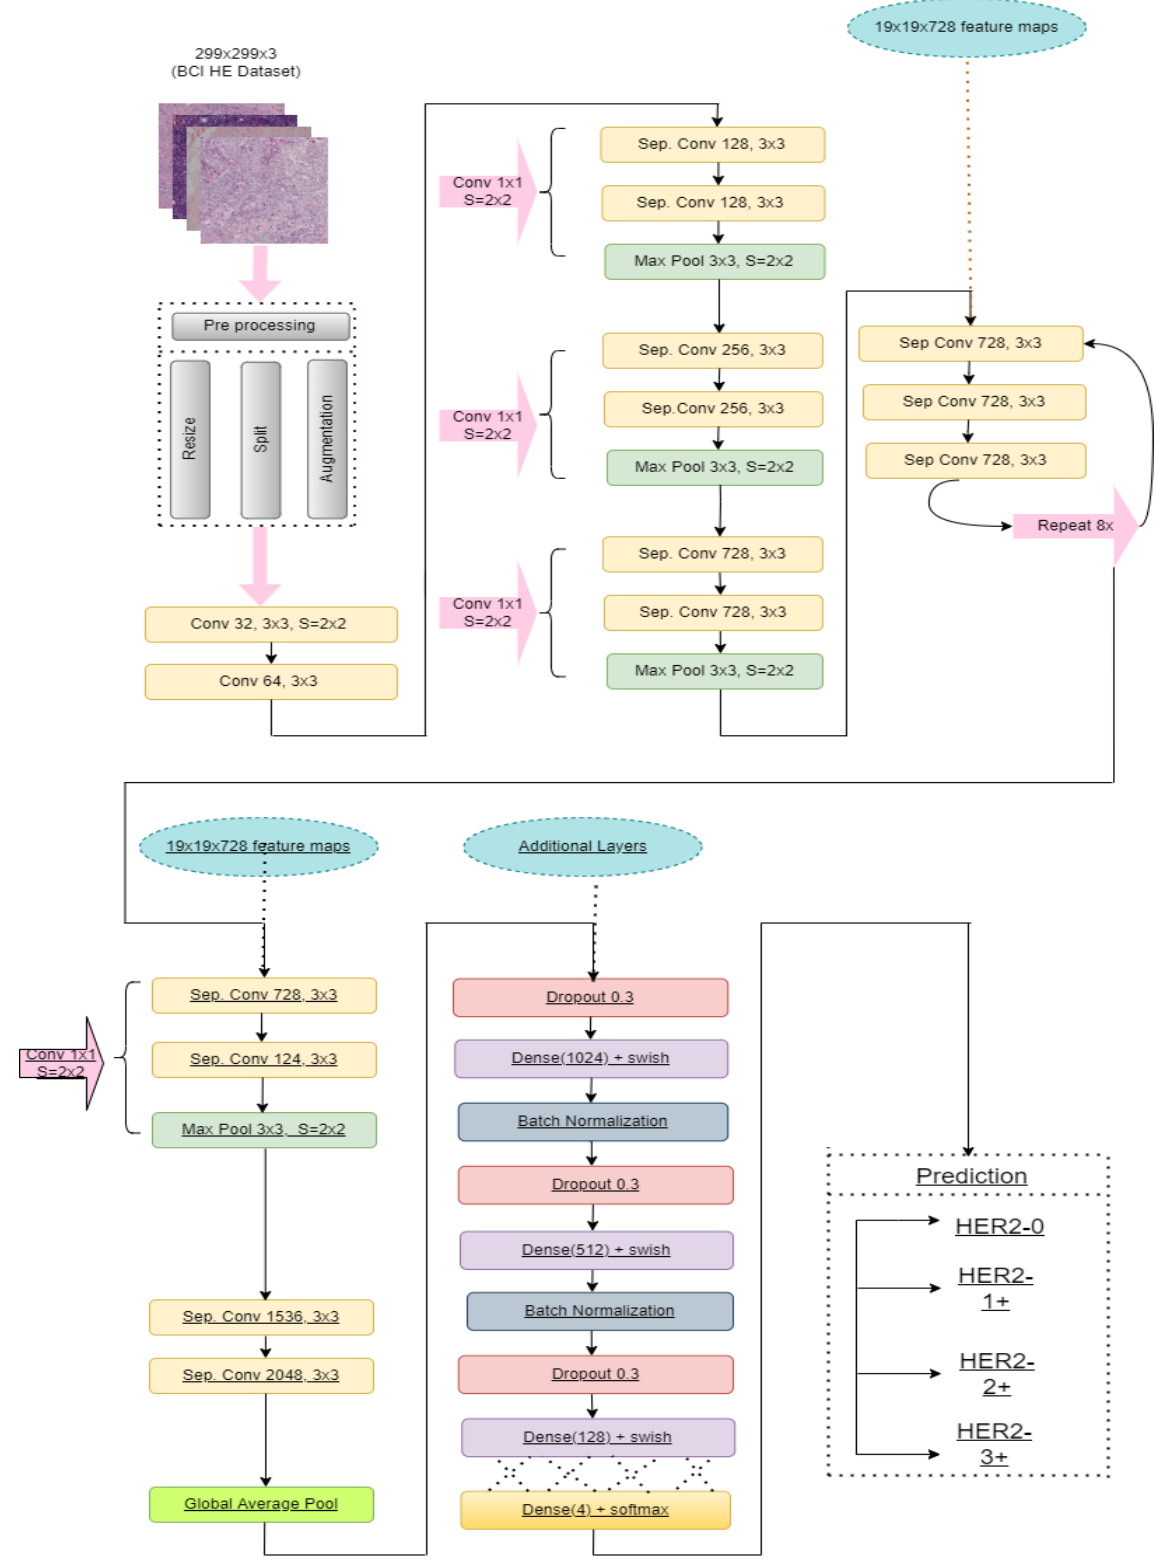
Figure 2. This figure illustrates the proposed model